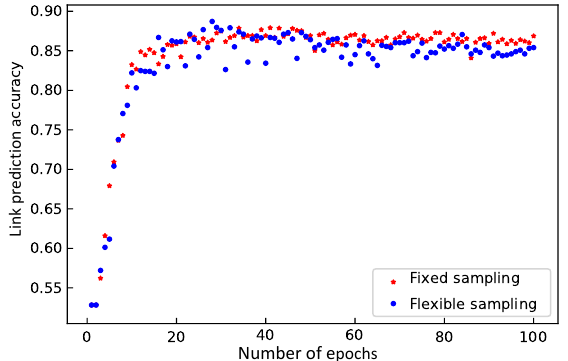
Fig. 4 Link prediction accuracy of the test set of Cora graph under different sampling strategies over training epochs. The red stars represent the accuracy from the fixed sampling strategy. Here, we sample only once before the first epoch and then keep all neighborhoods fixed during the whole training process. The blue dots represent the accuracy of the flexible sampling strategy, and we sample different neighborhoods before each training